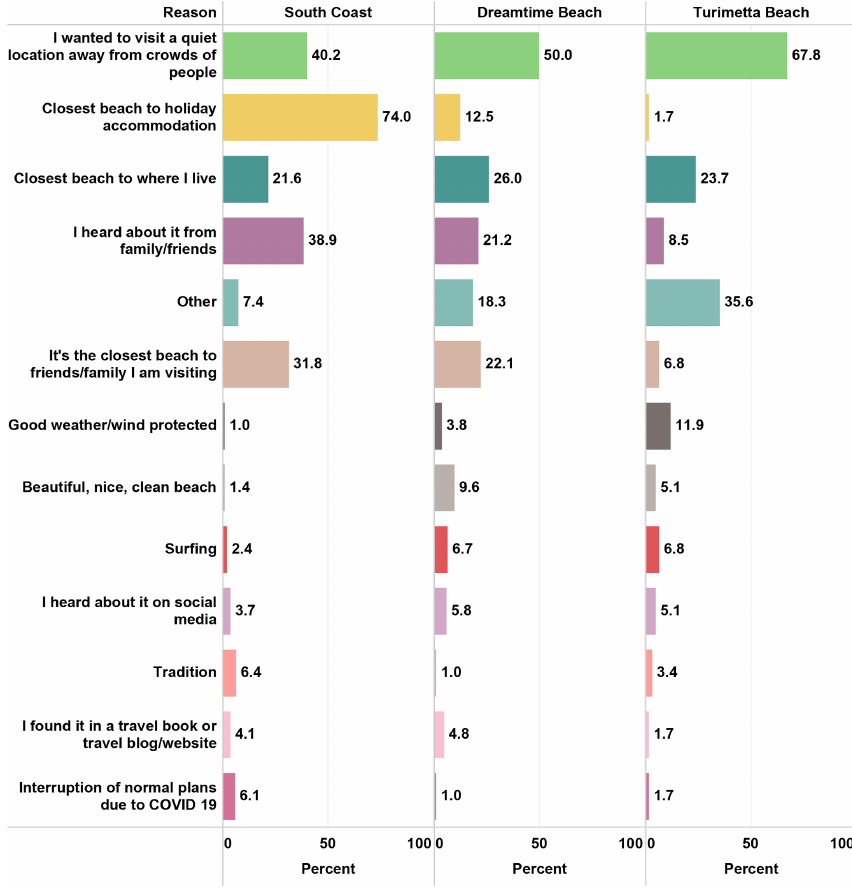
Figure 2. Most cited reasons why surveyed beachgoers visited unpatrolled beaches. Values next to coloured bars are percentages (%). The total number of responses exceeds 100% as each respondent could name up to three reasons. The number of times a reason was mentioned was divided by the number of beachgoers (South Coast: n = 296, Dreamtime Beach: n = 104, Turimetta Beach: n =